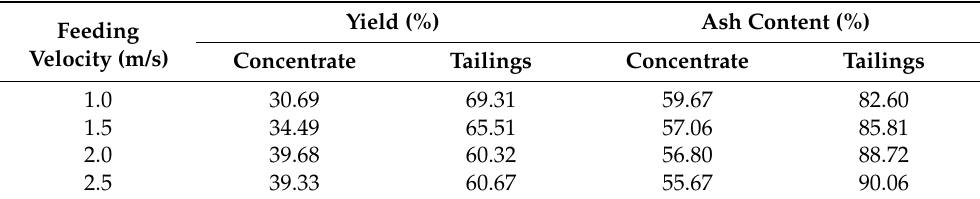
Figure 11. Wrap angle values of samples for different feeding velocities. Table 2. Flotation products yield and ash content for different feeding velocities.